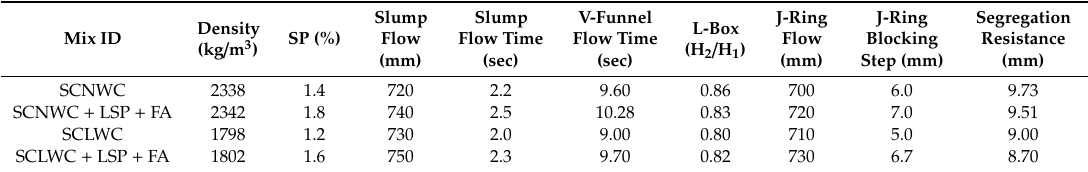
Table 4. Fresh state properties of